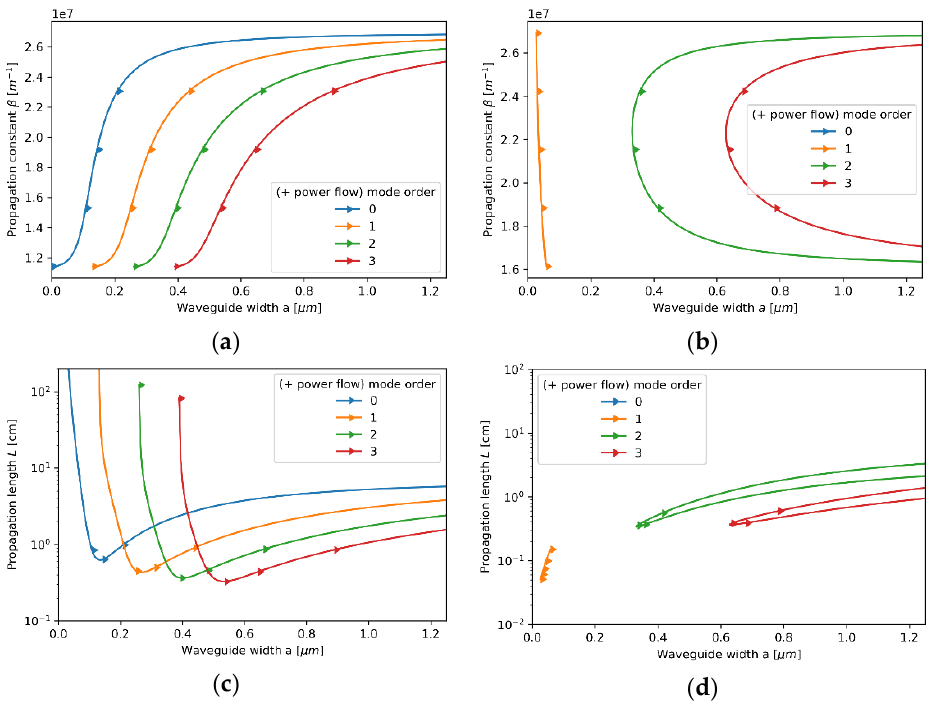
Figure 10. Propagation constant ( a , b ) and propagation length ( c , d ) of TM modes plotted versus waveguide width for an HMM waveguide with Nb2O5 layer of t Nb2O5 = 110 nm embedded in the unit cell and described with local ( a , c ) and nonlocal EMT ( b , d ).